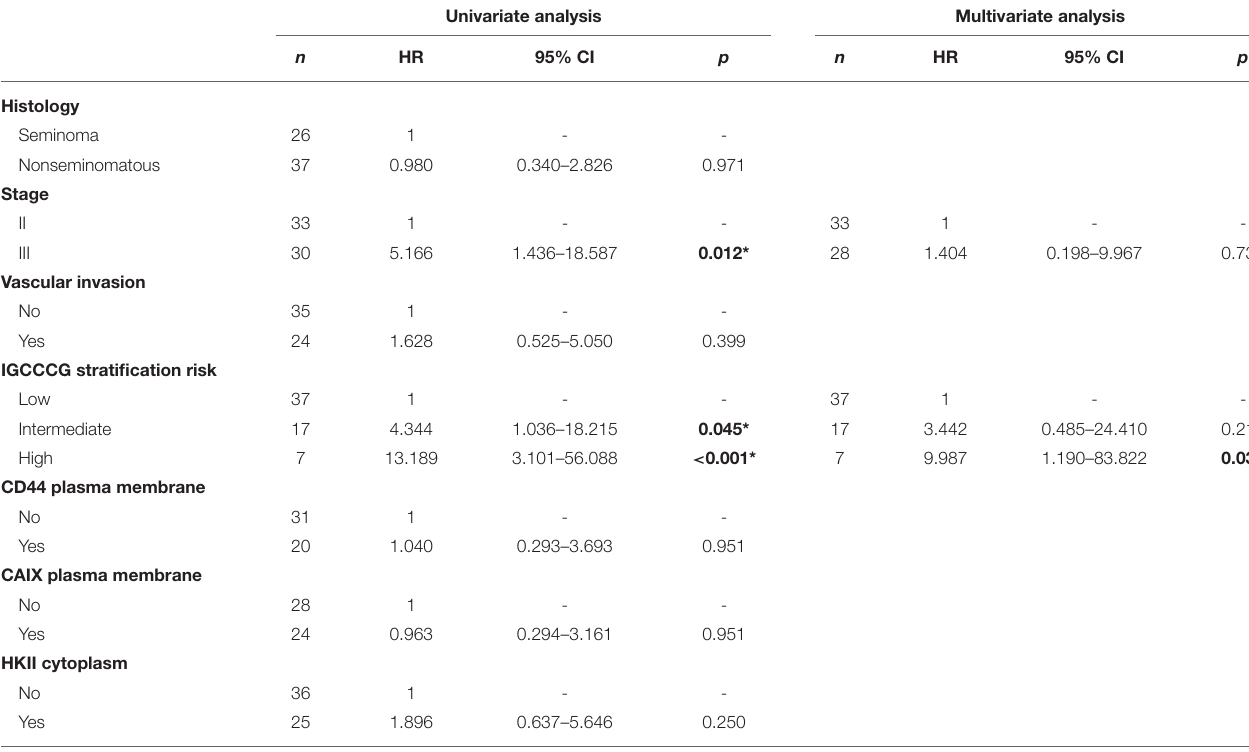
TABLE 4 | Prognostic factors for overall survival in adult testicular germ cell tumors. Univariate analysis Multivariate